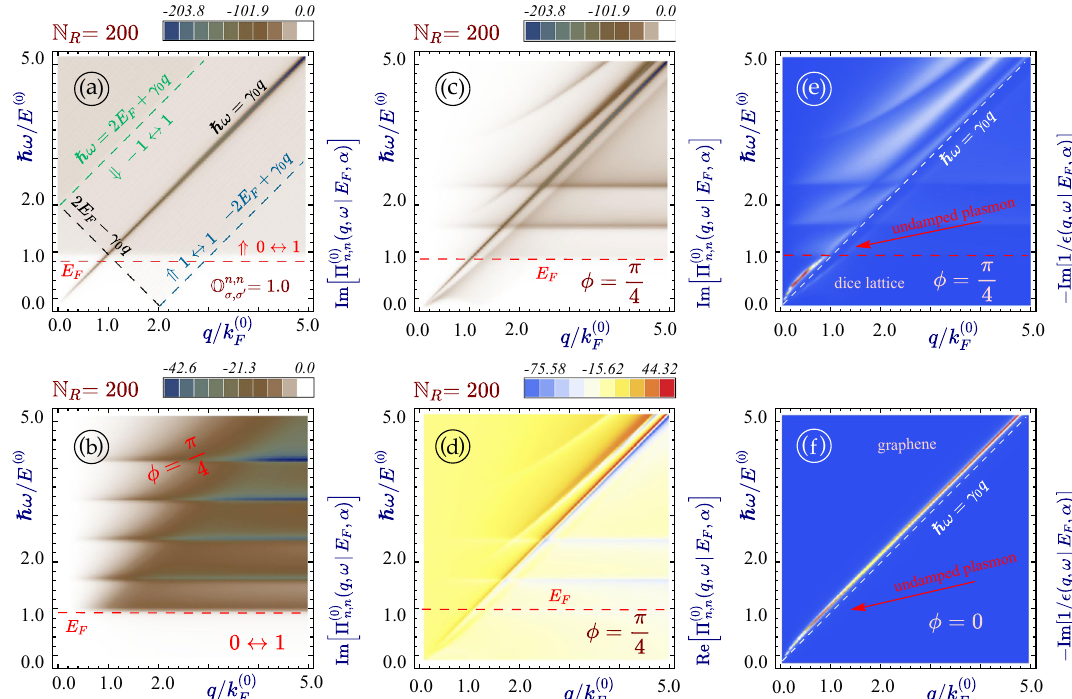
( 0 ) , ω E F , α) , single-particle excitation spectrum and n , n ( q y | 200 and N 0 1 )/ 3 67 . Panel ( N R = = + = 0, 1 ) are set to unity with an equal ( k y , q y ) ( σ 1,2 1 ↔ σ 2 = ± ( 0 ) ( q y , ω E F , α) . Panel ( b ) shows the contribution of transitions from and to the flat band n , n ′ | , n , q ) 0 , for a dice lattice with φ π/ 4 . Panels ( c ) and ( d ) display the imaginary 1 1 ( k y = = ( 0 ) , ω ± ↔± E F , α) for a dice lattice when all nine intra-band and inter-band transitions are n , n ( q y | 0 , separately. Other parameters π/ 4 and φ E F , α) for a dice lattice and graphene with φ = | =